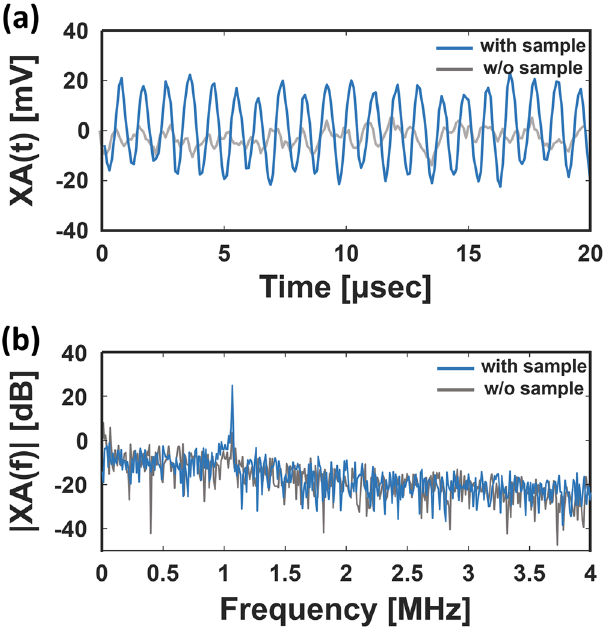
Figure 2. ( a ) X-ray induced acoustic (XA) signal in the time domain with and without the target. ( b ) XA signal in the frequency